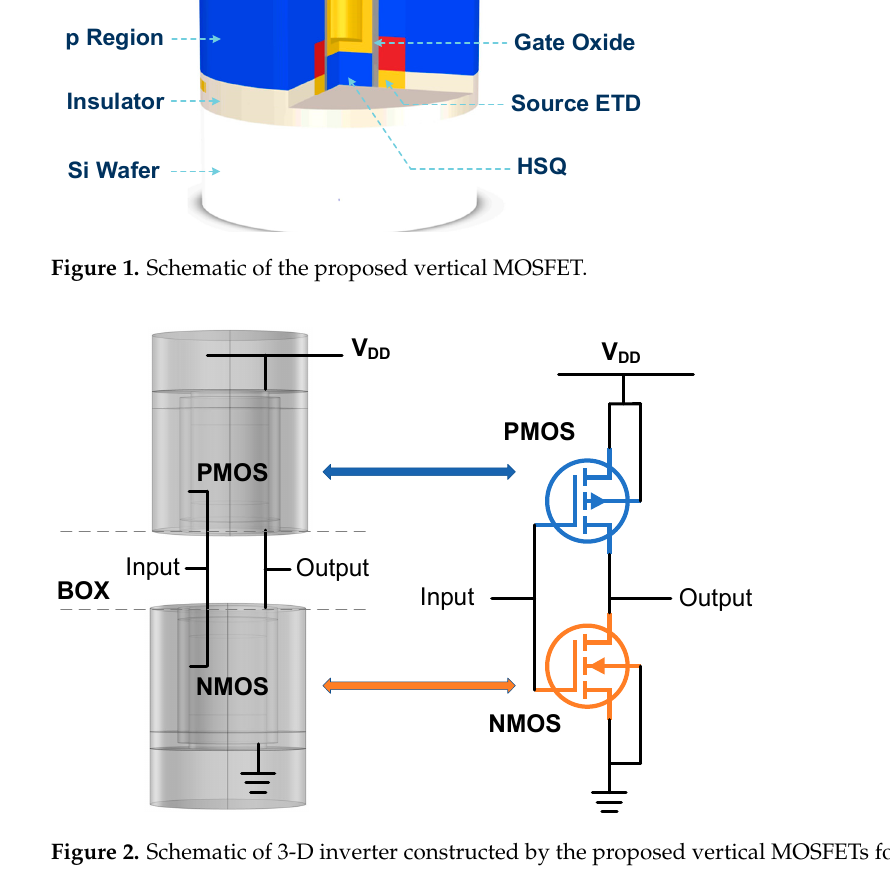
Figure 1. Schematic of the proposed vertical MOSFET.